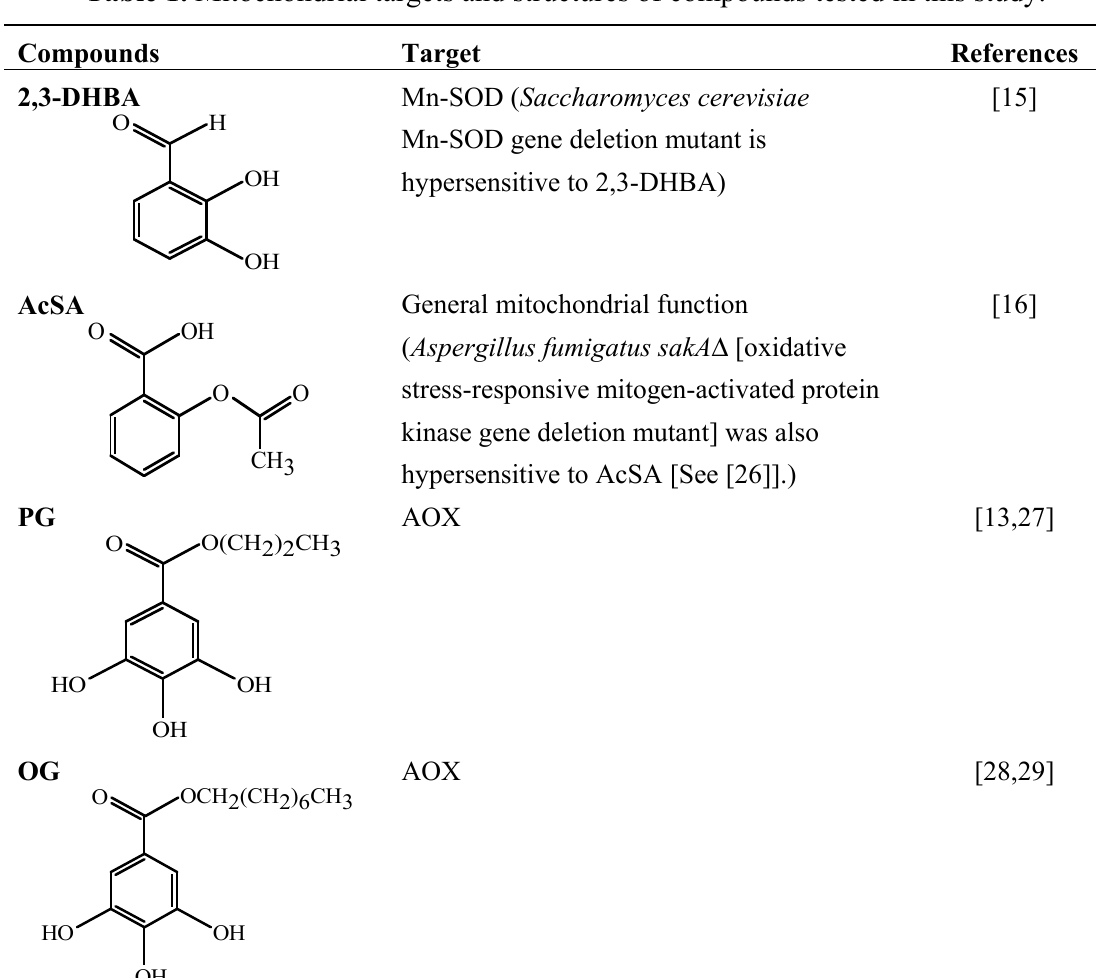
Table 1. Mitochondrial targets and structures of compounds tested in this